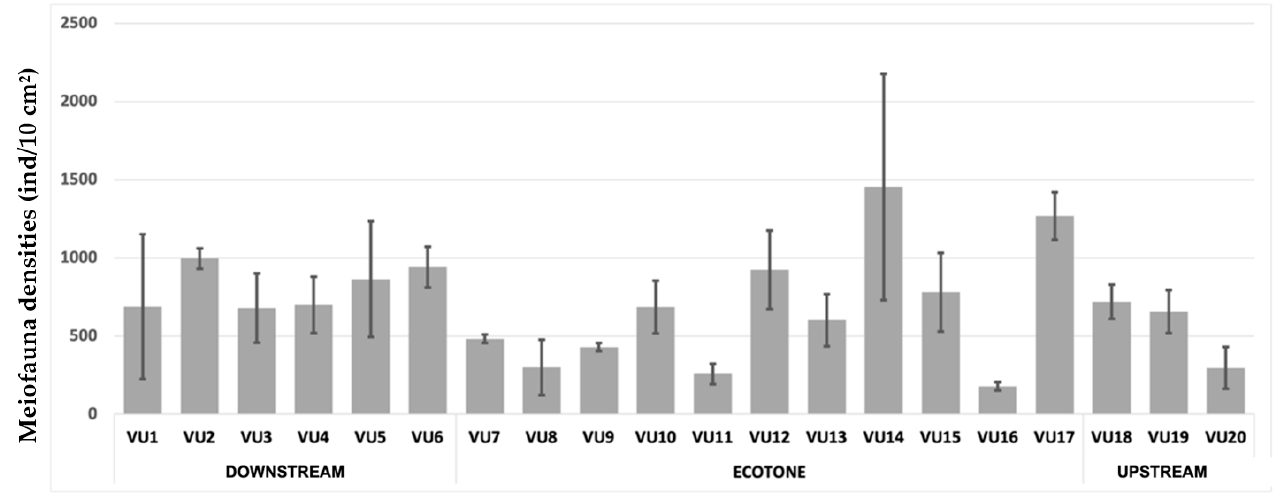
Figure 4. Meiofauna densities (mean ± SD/10 cm 2 ) along the Van Uc River. A total of 23 taxa were identified along the Van Uc River during the sampling period, with Nematoda the most dominant taxon (72.6%), followed by Rotifera (19.1%), Copepoda (2.2%), nauplii (1.1%), and others (4.1%). The “others” category contained all meiofaunal taxa whose percentage of representation was less than 1%, including Bivalvia (0.89%), Foraminifera (0.83%), Oligochaeta (0.74%), Polychaeta (0.6%), Amphipoda (0.55%), Turbellaria (0.35%), Ciliophora (0.33%), Ostracoda (0.13%), and Sipuncula (0.11%), together with some taxa presented at a very low density (less than 0.1%) such as Insecta, Kinorhyncha, Gastrotricha, Acari, Nemertea, Cumacea, Bryozoa, Isopoda, Gas- tropoda, and Tanaidacea.